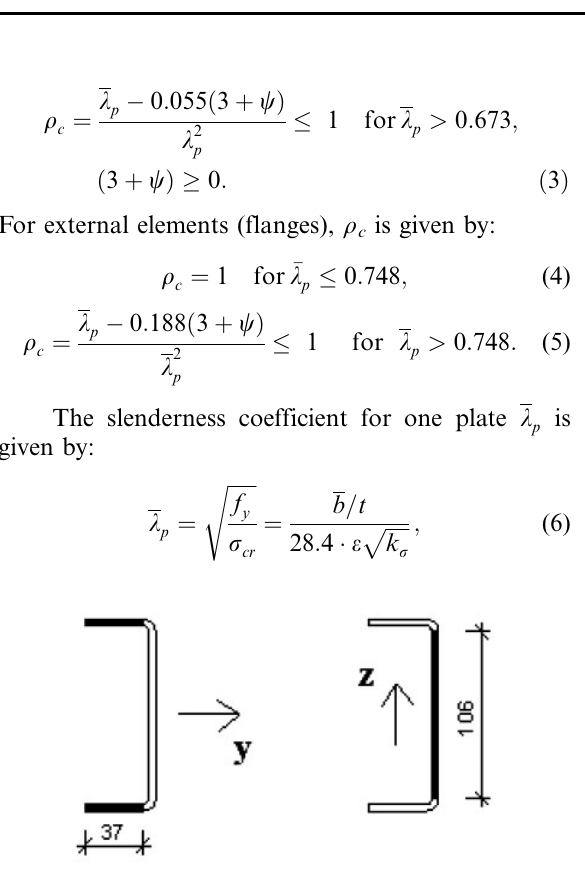
Fig. 3. Definition of shear areas (section BCM1) Fig. 4. Modeling of the trapezoidal